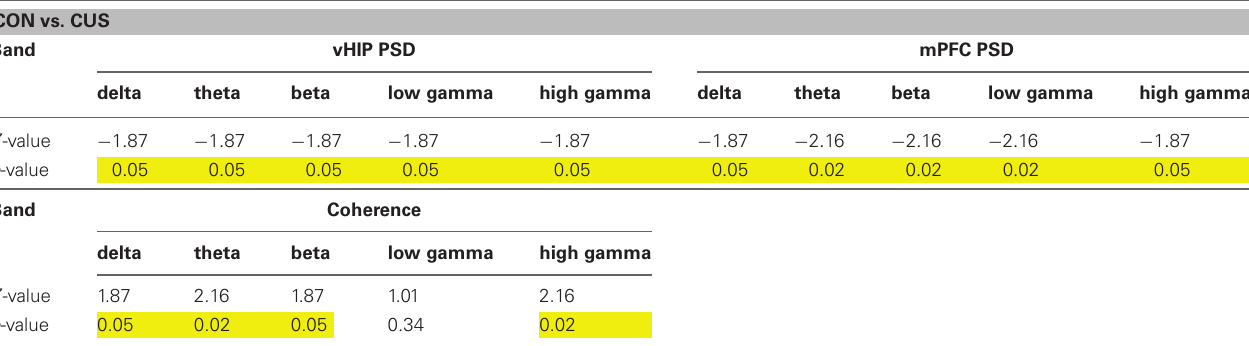
Each table represents the Z- and p-values of pairwise comparisons of vHIP PSD, mPFC PSD, and coherence values in the control (CON) and chronic unpredictable stress (CUS) groups. These values correspond to the graphs presented in Figure 4 . Comparisons made by Mann–Whitney test; statistical significance is highlighted in yellow (p ≤